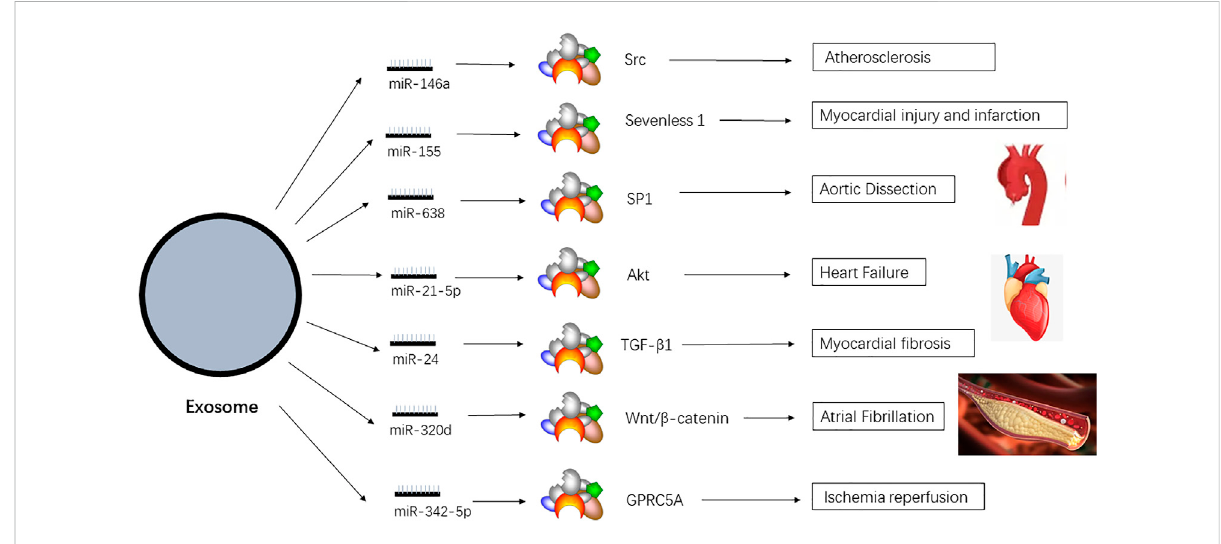
Exosomal miRNAs which are related to cardiovascular diseases. There are various miRNAs in the exosomes, and they depend on the special pathway to affect the diseases.